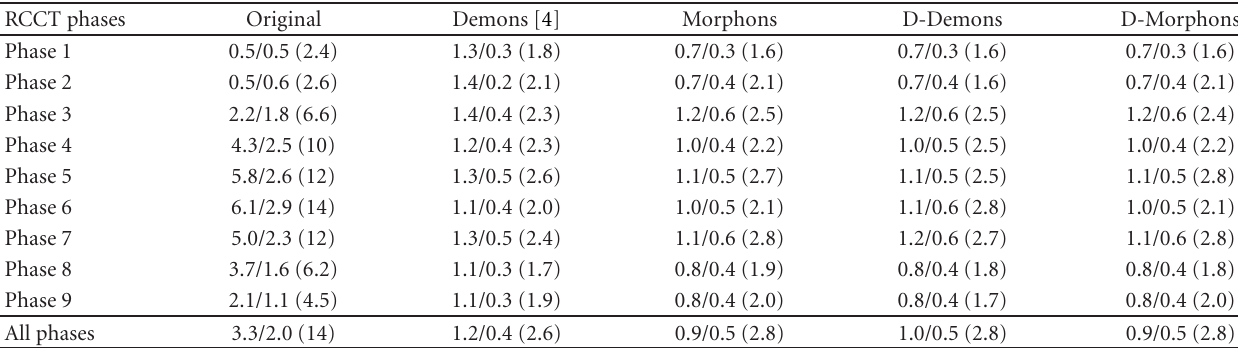
Table 2: Results for the POPI experiment: error in landmark position.